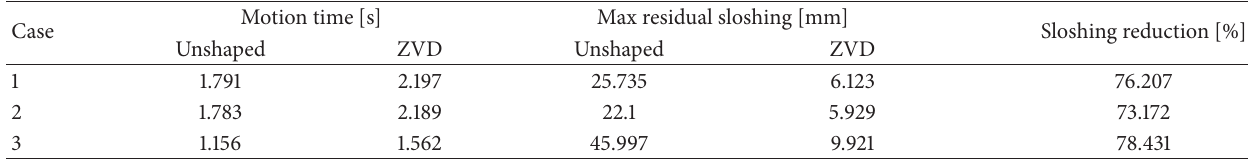
Table 4: Result of